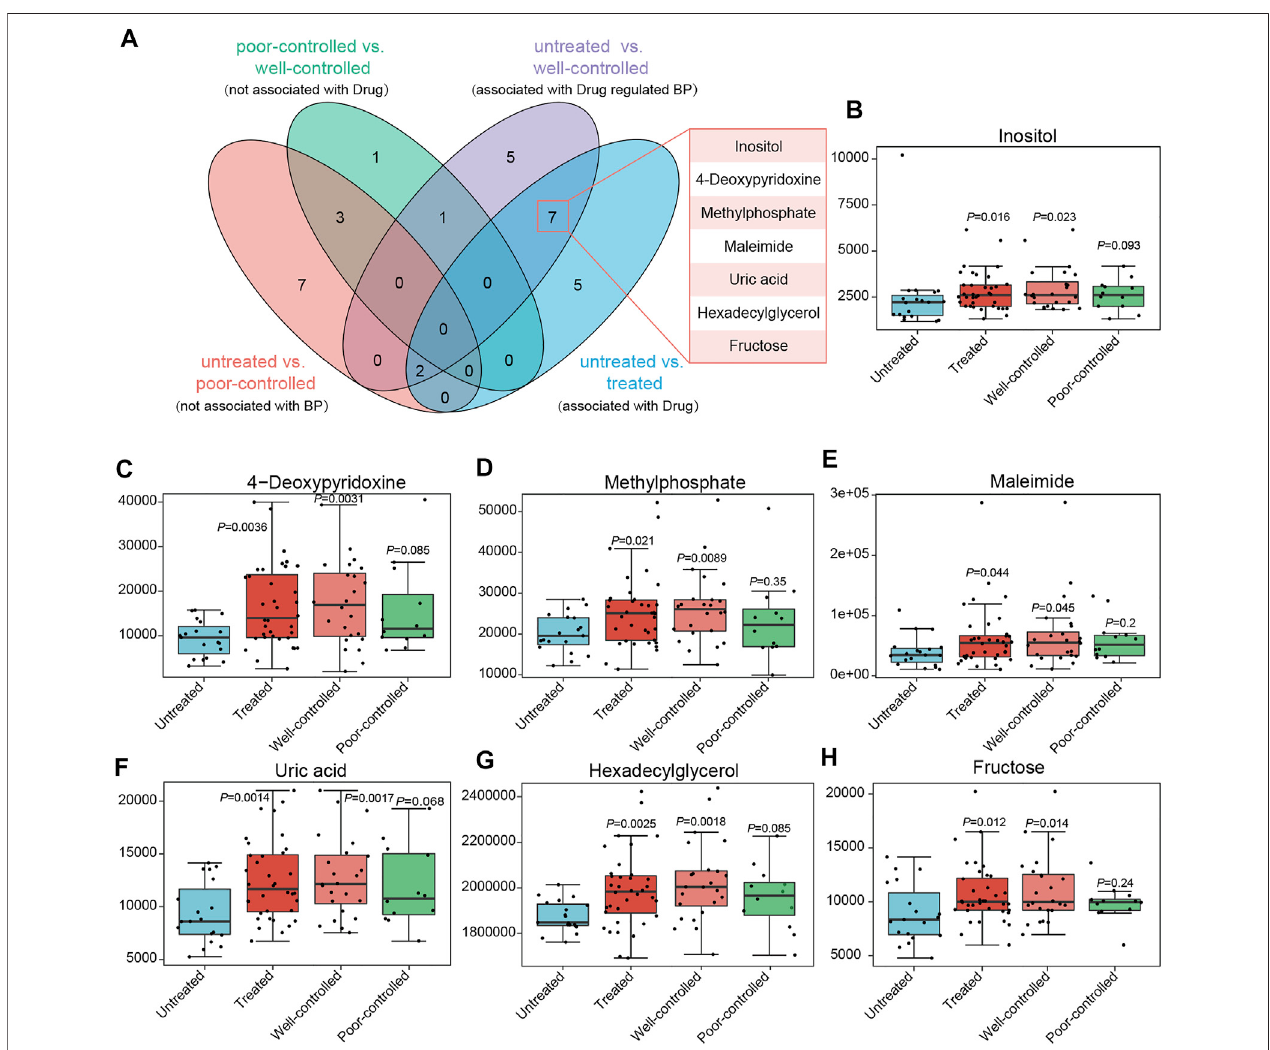
FIGURE 7 | Core metabolites signi fi cantly altered between groups, possessing potential association with medical treatment or BP regulation. (A) Venn diagrams indicate the metabolites in different groups. The variables different between the untreated and poor-controlled groups are considered as not associated with BP attenuation;those between thepoor-controlledand well-controlledgroups arenot attributed toACEI/ARBtreatment;variables derived from untreated vs. treated might be linked to drug therapy; when comparing the untreated and well-controlled groups, it is intended to obtain serum metabolites related to BP regulation by ACEI/ ARB administration. Potential metabolites important for ACEI/ARB in lowering BP are concentrated in 7. (B – H) Relative abundance of inositol, 4-deoxypyridoxine, methylphosphate, maleimide, uric acid, hexadecylglycerol, and fructose in ACEI/ARB-treated HTN patients either well-controlled or poor-controlled.